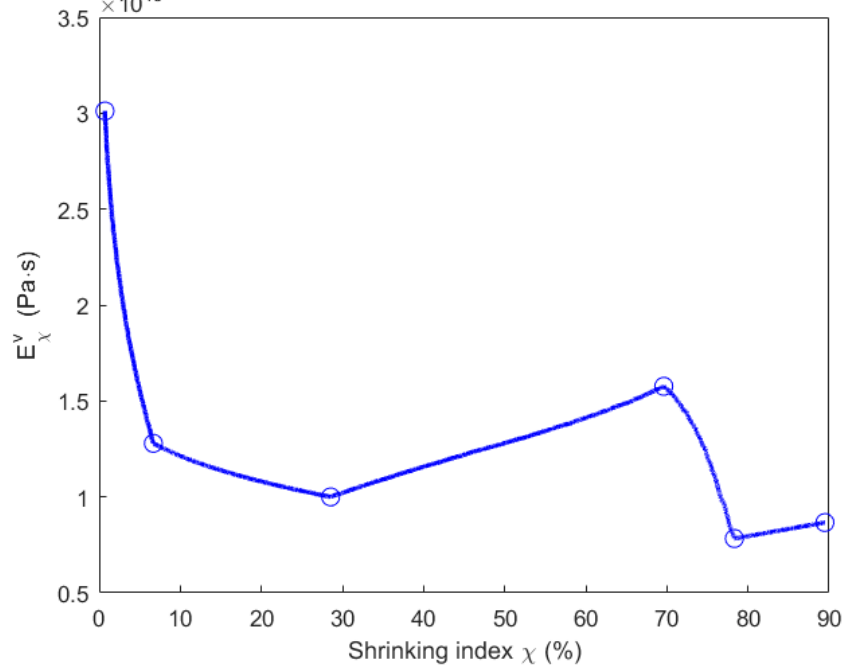
v E χ with respect to the shrinking index.